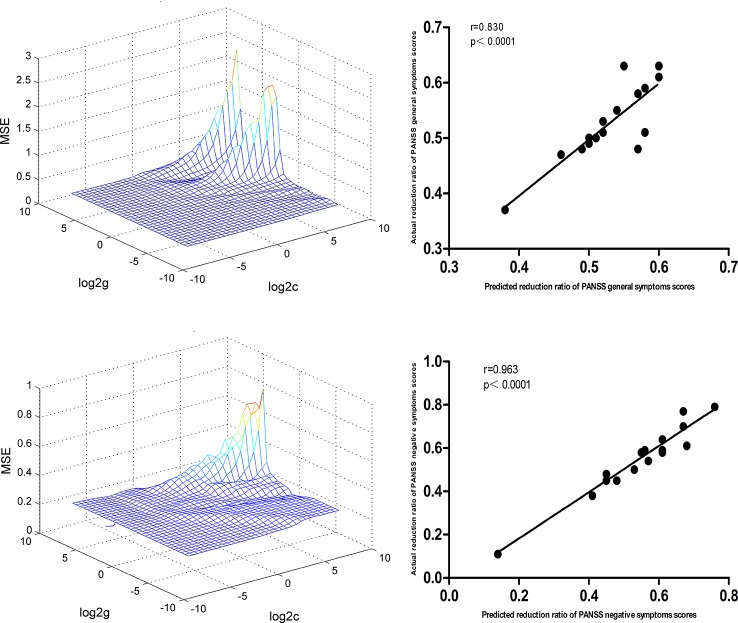
SVR results suggested that the high NH levels at baseline in the bilateral superior MPFC could predict therapeutic response in the DPP group. Left: SVR parameter selection results (3D visualization); Right: The positive correlations between predicted and actual RR of the PANSS general symptoms subscale scores (r=0.830, p < 0.0001) and negative symptoms subscale scores (r=0.963, p < 0.0001) of the individual patients after 8 weeks of DPP treatment. PANSS, Positive and Negative Syndrome Scale; RR, reduction ratio.